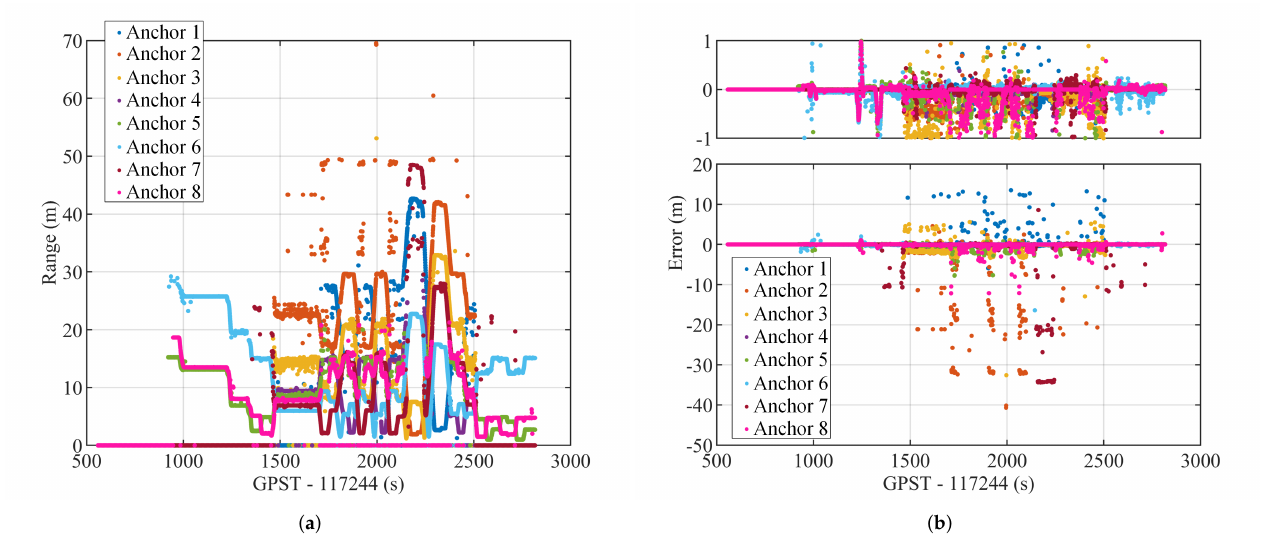
Figure 9. Time series of the ranging values and errors for different UWB anchor nodes. ( a ) Ranging values. ( b )